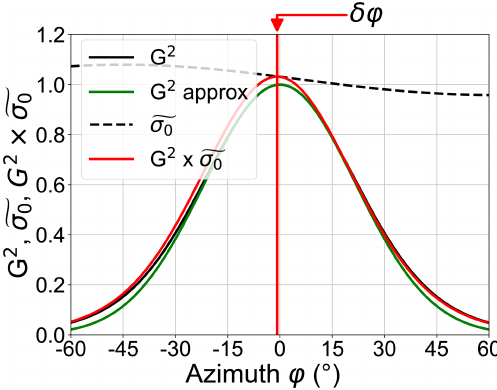
Figure 2. KuROS azimuth integral weight at θ = 12 ◦ for a north-facing ( ϕ b = 0 ◦ ) antenna (black), Gaussian approximation (Eq. A29) (green) and variation of (cid:101) σ 0 for a typical 11ms − 1 wind from 140 ◦ (dashed black). The peak of the (cid:101) σ 0 G 2 product (red) is shifted with respect to the peak of G 2 by δϕ (cid:39) − 0 . 81 ◦